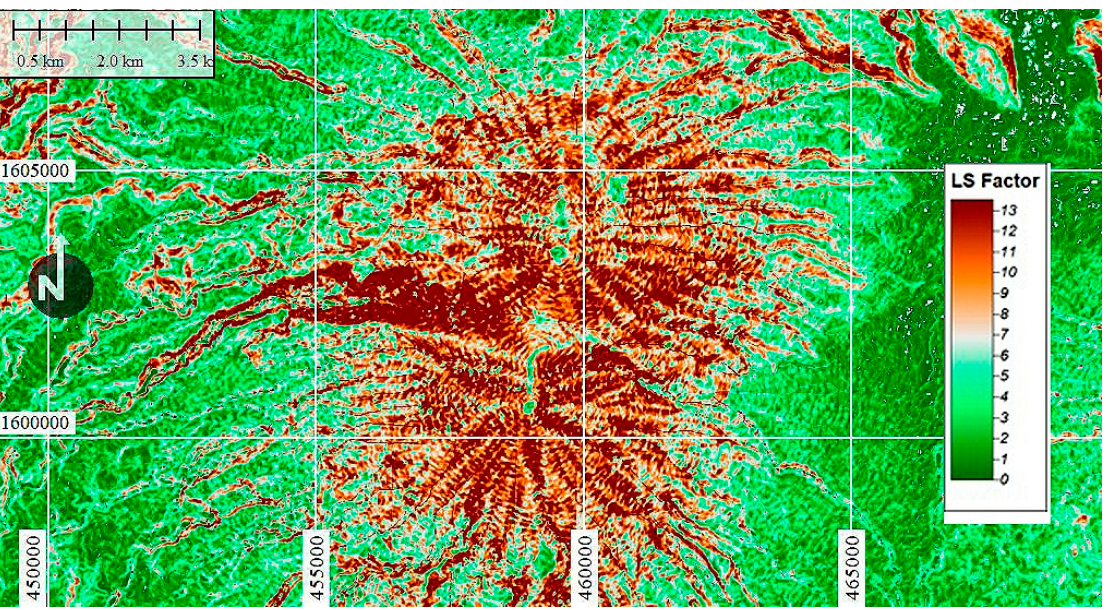
Figure 9. LS-factor (slope length and steepness factor) calculated in SAGA geographic information system (GIS). The low susceptibility to erosion is represented with green colors and the high with brown color.